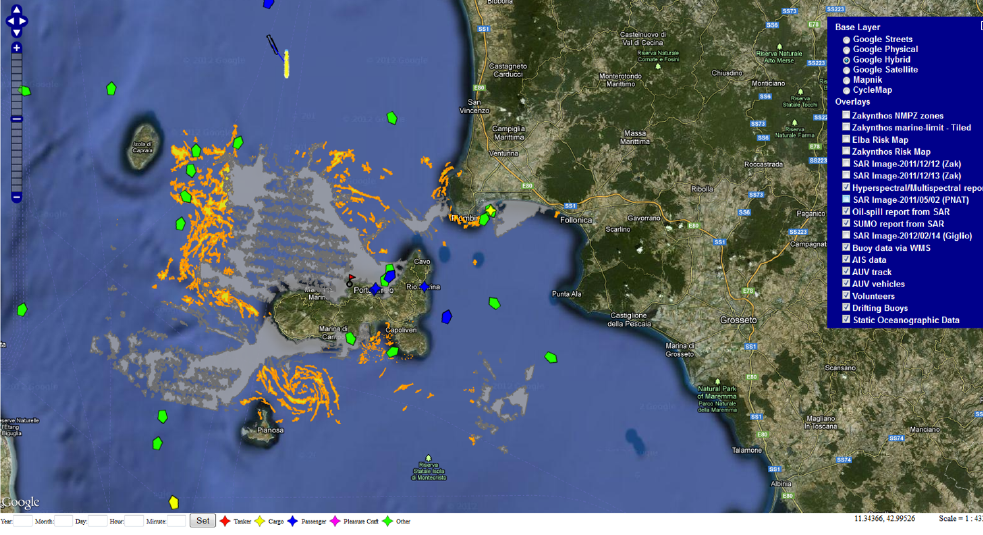
Figure 3. The MIS interface with the map a view with several overlay layers, as well as all the available layers. (scale 1 cm:10 km).